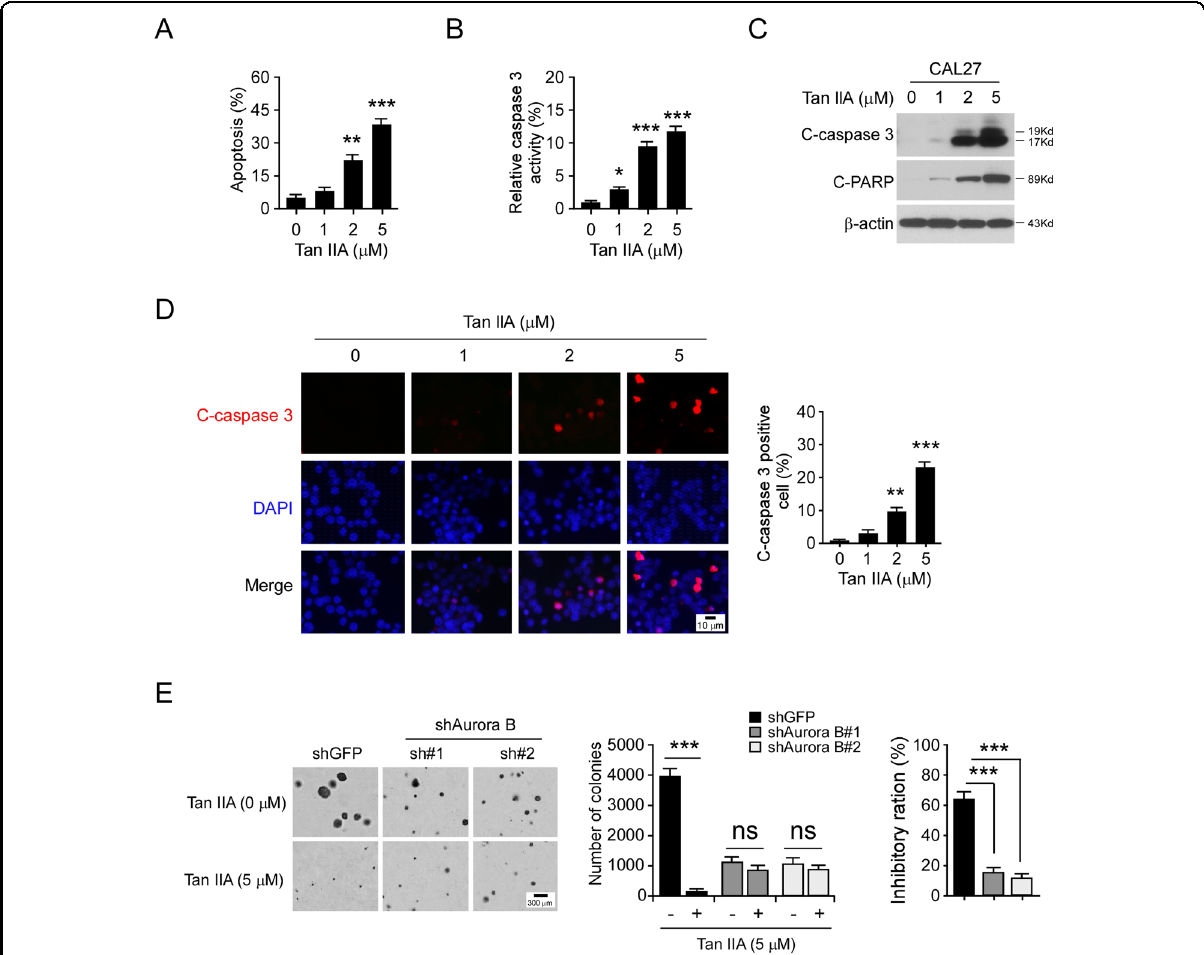
Fig. 5 Tan IIA promotes apoptosis in OSCC cells. A Flow cytometry examination of apoptotic CAL27 cells with Tan IIA treatment for 72 h; n = 3 independent biological replications, one-way ANOVA; ** p < 0.01, *** p < 0.001. B and C CAL27 cells were treated with Tan IIA for 72 h, cell lysate was subjected to cleaved-caspase 3 activity analysis ( B ) and IB analysis ( C ). For B , n = 3 independent biological replications, one-way ANOVA; * p < 0.05, *** p < 0.001. D CAL27 cells were treated with Tan IIA for 72 h and subjected to IF analysis with cleaved-caspase 3 antibody. Scale bar, 10 μ m; n = 3 independent biological replications, one-way ANOVA; ** p < 0.01, *** p < 0.001. E Knockdown of Aurora B decreased the sensitivity to Tan IIA. Soft agar assay analysis of the anti-tumor effect of Tan IIA on shGFP and shAurora B-expressing CAL27 cells (left and middle), the inhibitory ratio of Tan IIA on colony formation was calculated (right); n = 3 independent biological replications, two-way ANOVA, *** p < 0.001; ns, not statistically signi fi